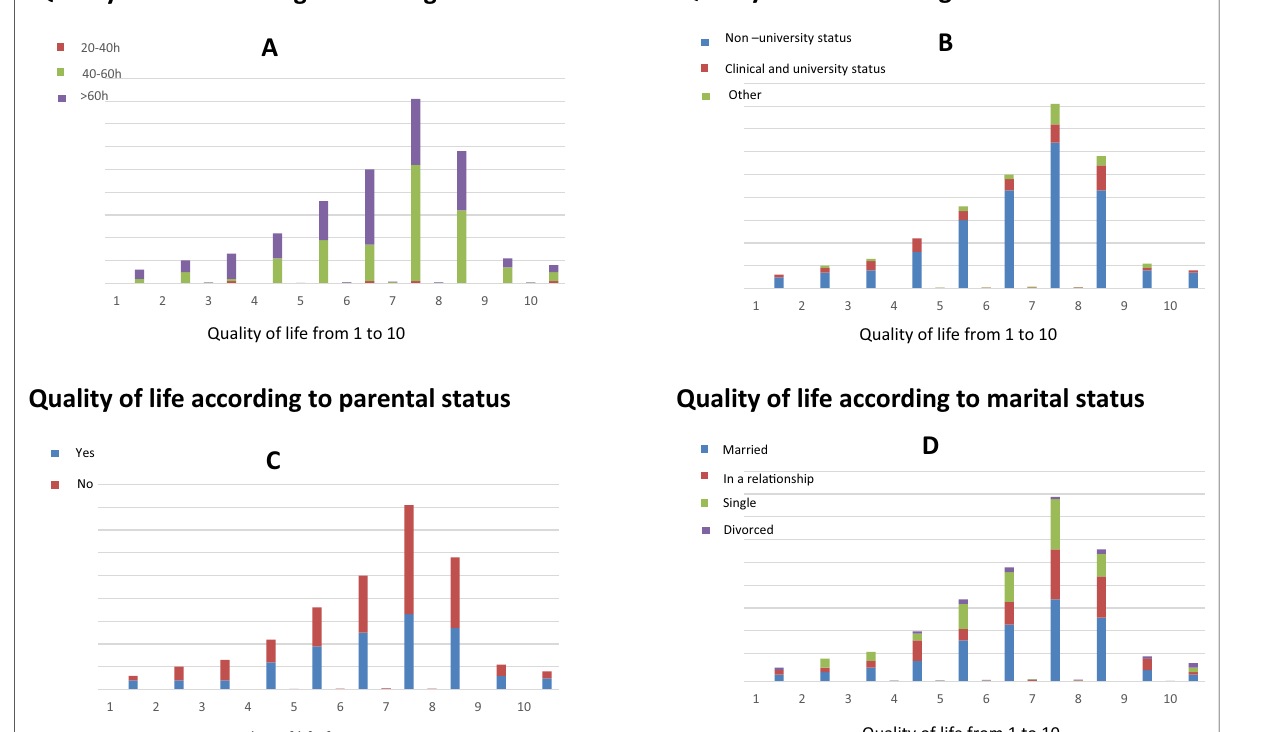
(Table 6). The different suggestions were: 1) adjusting working hours (including no planned meeting after 6 pm), but not necessarily working less and the possibility to work part-time when needed to allow a better balance